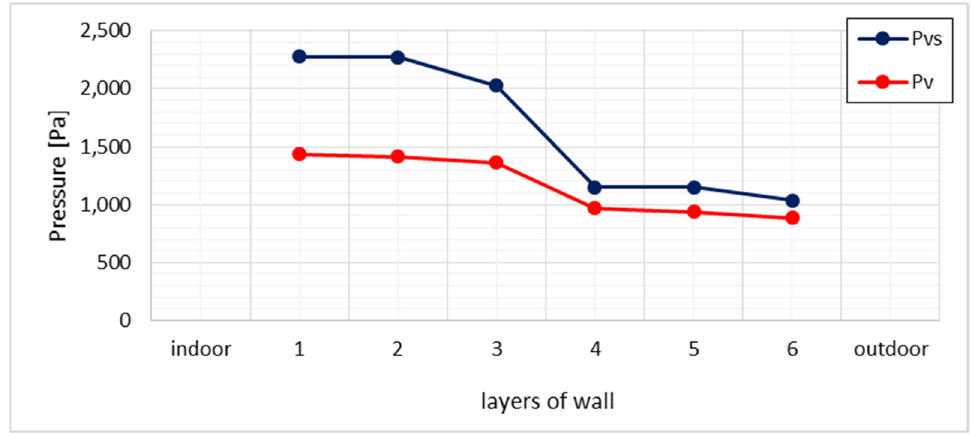
Figure 4. Glaser diagram: trend of saturation and vapour pressures throughout wall 1.